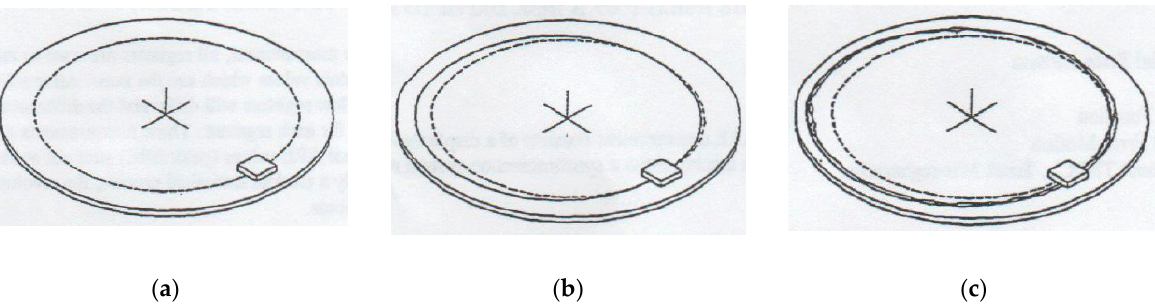
Figure 7. Graphical representation of synchronous and asynchronous errors [10]: ( a ) perfect disc rotating (with- out error movements); ( b ) disk with only synchronous error movement; and ( c ) real disc rotating (synchronous and asynchronous errors).